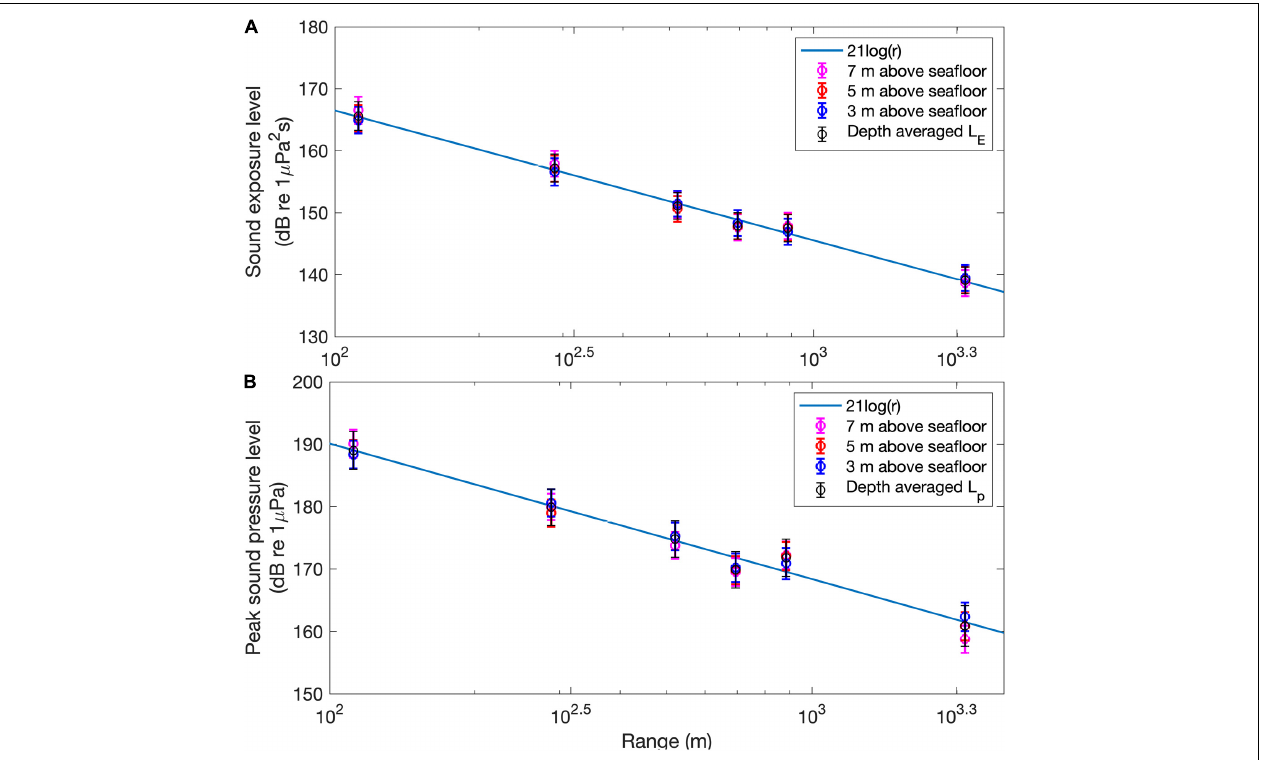
FIGURE 6 | (A) The sound exposure levels and (B) peak pressure levels estimated as a function of distance (blue, red, and magenta are those measured at 3, 5, and 7 m above the seafloor, respectively) and their comparisons with the regression curves corresponding to 21log r + C.